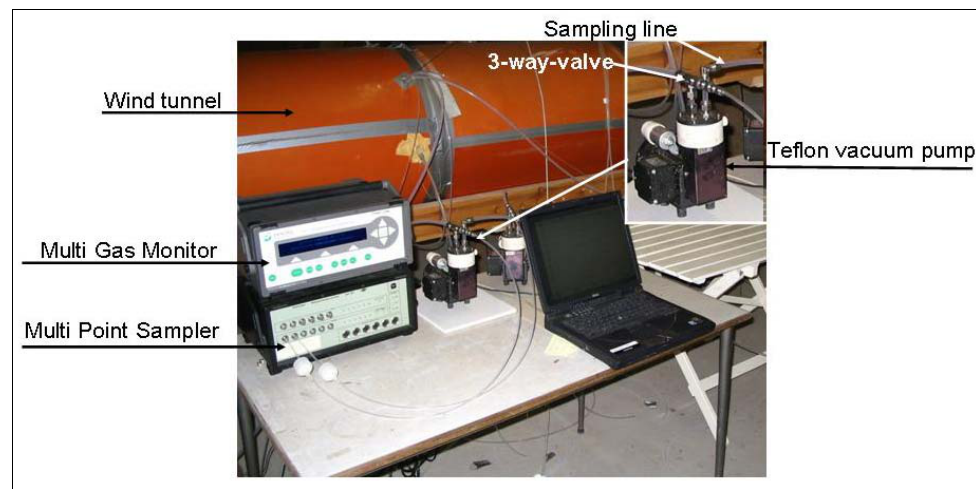
Figure 2 . Instrumentation